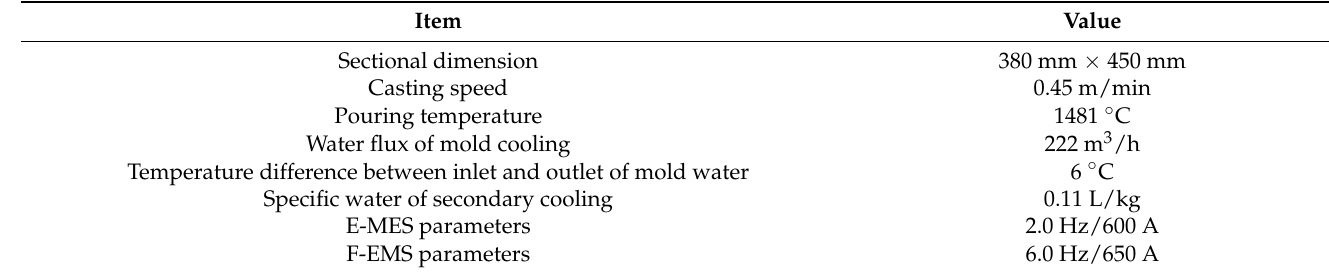
Table 2. Main casting parameters of steel bearing